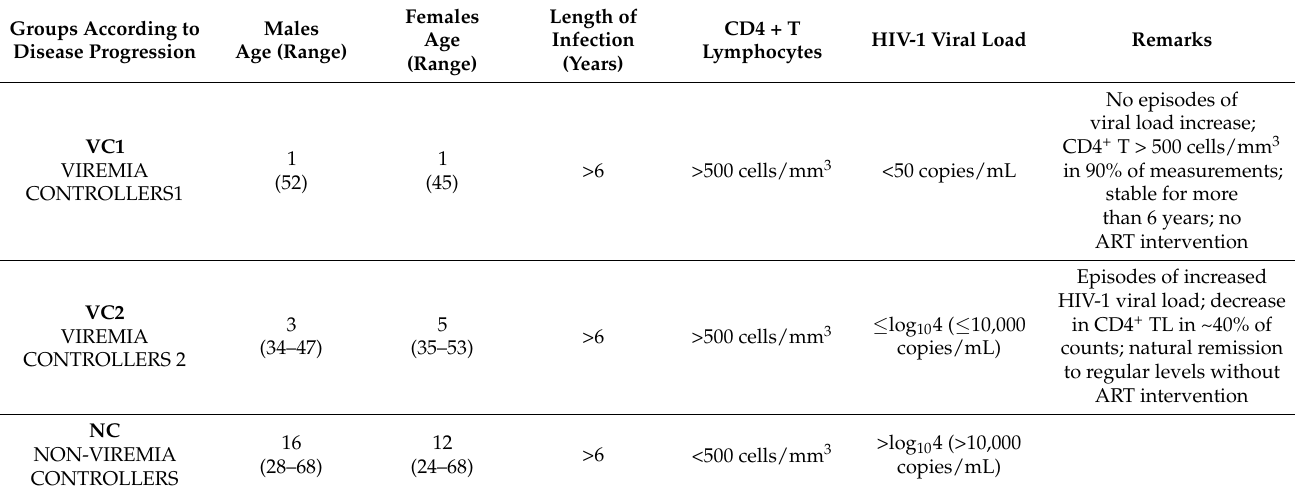
Table 4. Distribution of the groups examined, according to sex and age, and criteria for defining the viremia controller and non-controller